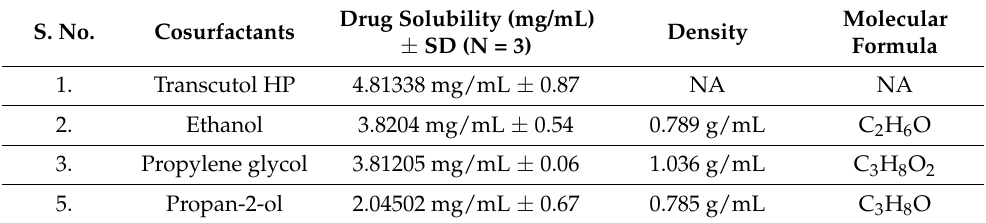
Table 3. Drug solubility in